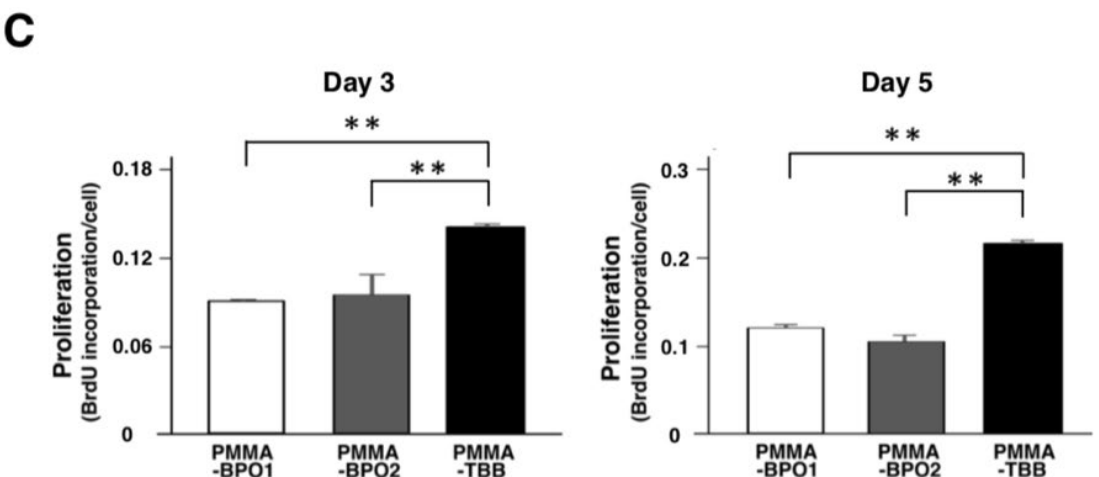
Figure 2. Evaluation of the proliferation of osteoblasts exposed to three different bone cement extracts. ( A ) The density of propagated cells after 3 and 5 days of culture was evaluated by manually counting cells using a hemocytometer. ( B ) Representative fluorescence microscopy images of propagated osteoblasts after 3 days of culture stained with rhodamine phalloidin for actin filaments (red) and 4′,6 -diamidino-2-phenylindole (DAPI) for nuclei (blue) at low magnification. ( C ) BrdU incorporation per cell measured at days 3 and 5. Data shown are mean ± SD ( n = 3). Significant differences between the three groups are shown (one-way ANOVA followed by Bonferroni correction, ** p < 0.01).